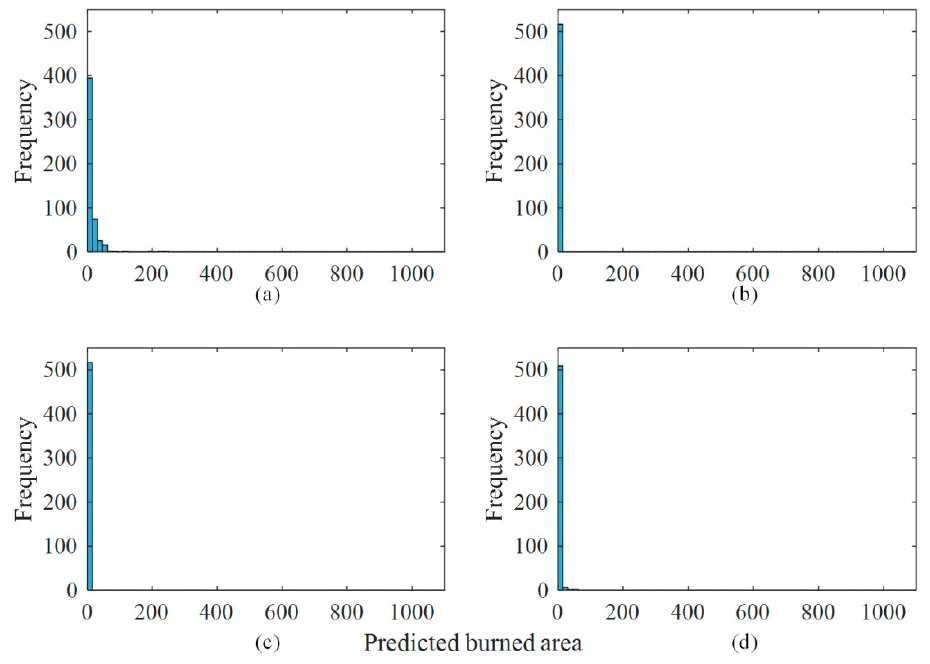
Figure 7. Histogram of predicted burned area provided by: ( a ) the proposed method; ( b ) SVM; ( c ) ANN; ( d ) RF, respectively.